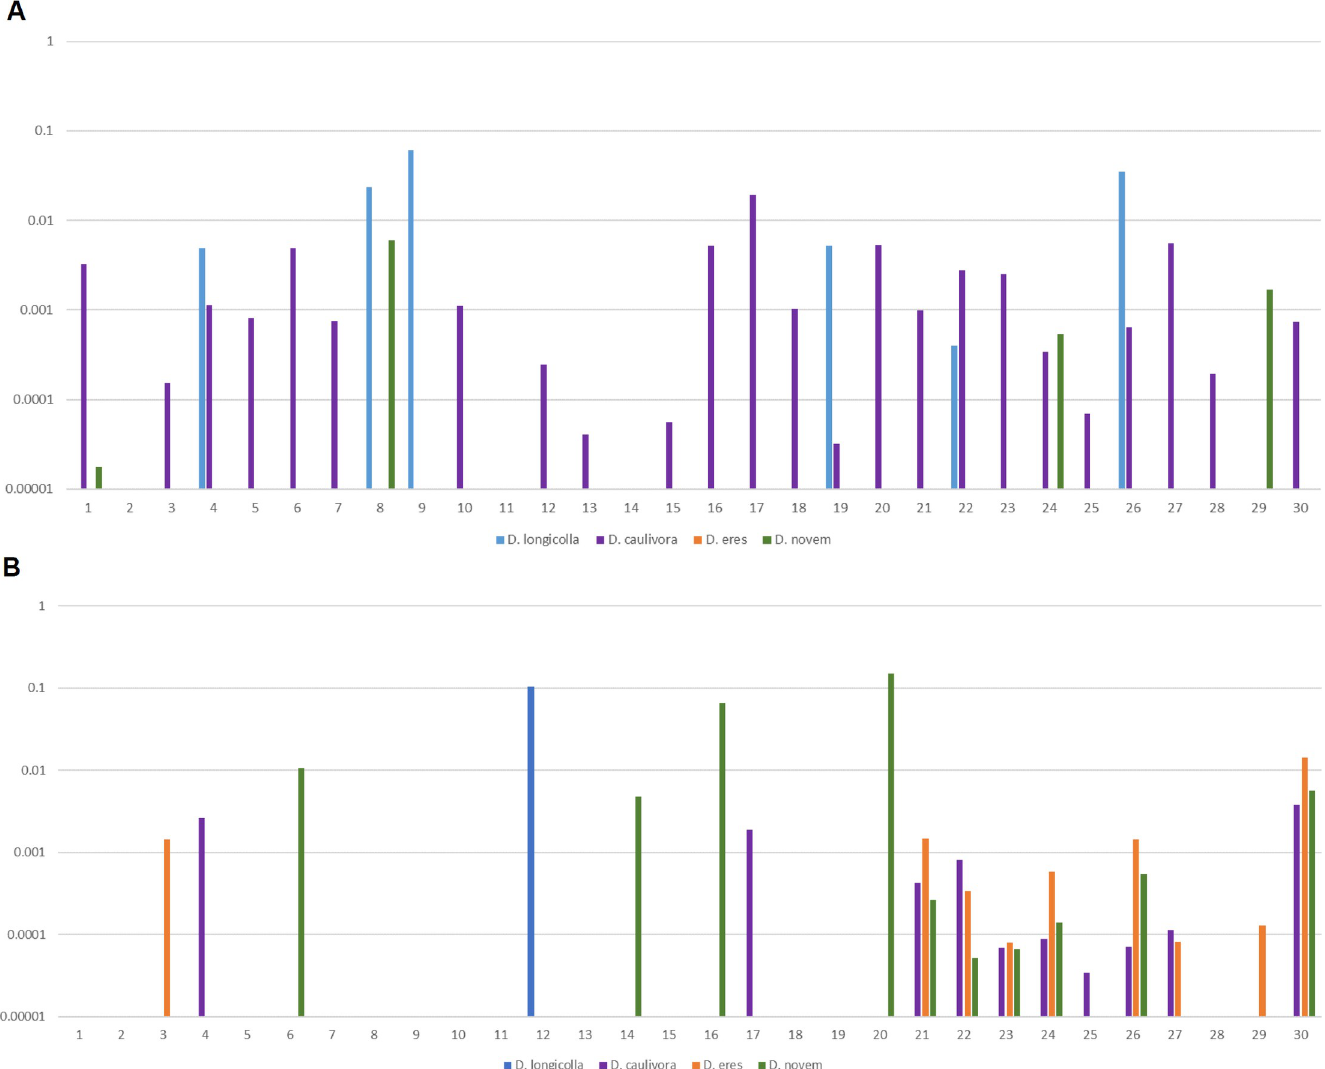
Fig 6. Sampling soybean seed lots via the quadruplex real-time PCR assay. (A) First seed lot, from a field in Oberweiden, Austria. (B) Second seed lot, from a field in Ebergassing, Austria. Bars represent ng Diaporthe DNA/ng soybean DNA; because of the strong variation a logarithmic scale was chosen. The numbers on the x-axis represent the 30 seeds that were individually